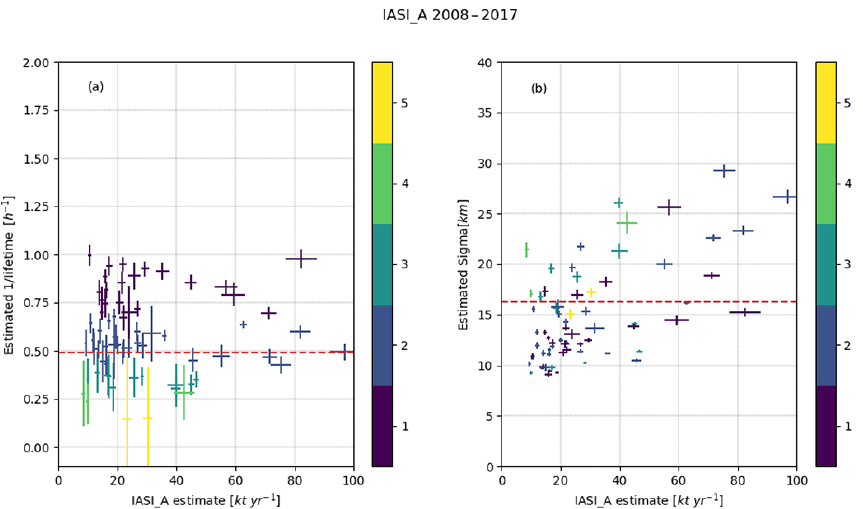
Figure C3. All successful fits for the 10-year (2008–2017) IASI-A dataset with a correlation > 0.5 and a SNR > 2. Panel (a) shows the fitted emissions vs. the λ parameter and (b) the fitted emissions vs. the fitted σ with the horizontal and vertical error bars showing the uncertainties of the fit. The color of the bars indicates the fitted lifetime rounded to the nearest integer. The horizontal striped red lines show the weighted average of the λ and σ